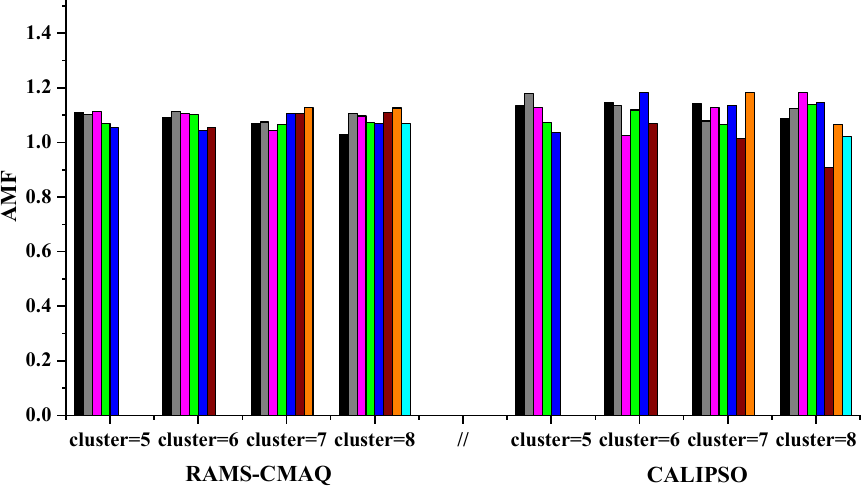
Figure 7. The aerosol extinction coefficient (AEC) clusters: ( a ) Regional Atmospheric Modeling System and Models-3 Community Multi-scale Air Quality (RAMS-CMAQ); ( b ) CALIPSO (N AEC : 5–8).